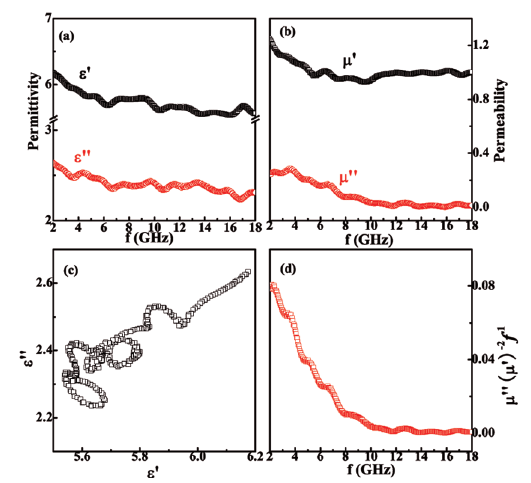
Figure 3: (a) Complex permittivity and (b) permeability, (c) Cole-Cole semicircles and (d) values of ’’ ’ f 2 1 n n - - of frequency for the composite with 40 wt% NiFe